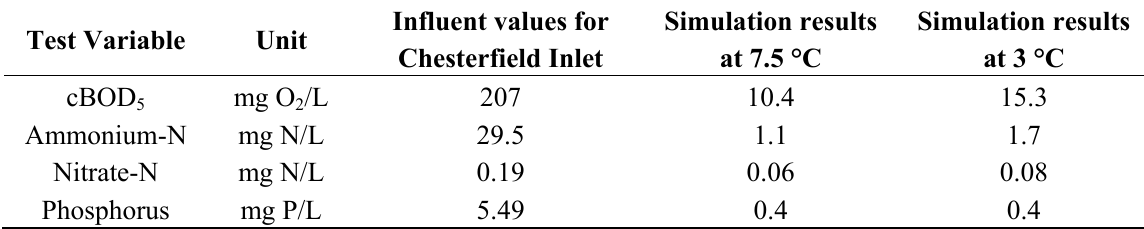
Table 4. Simulated treatment response of the Chesterfield Inlet wetland (no pre-treatment) at the two different temperature regimes of 7.5 °C and 3